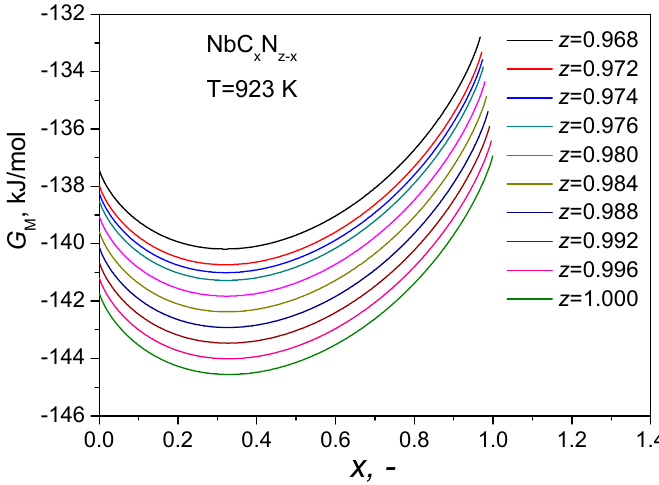
Figure 8. Dependence of the Gibbs energy ( G M ) of the NbC x N( z − x ) carbonitrides on the fraction of carbon sites (x) under different values of the total fraction of non-metal sites (z) at the aging temperature (923 K).